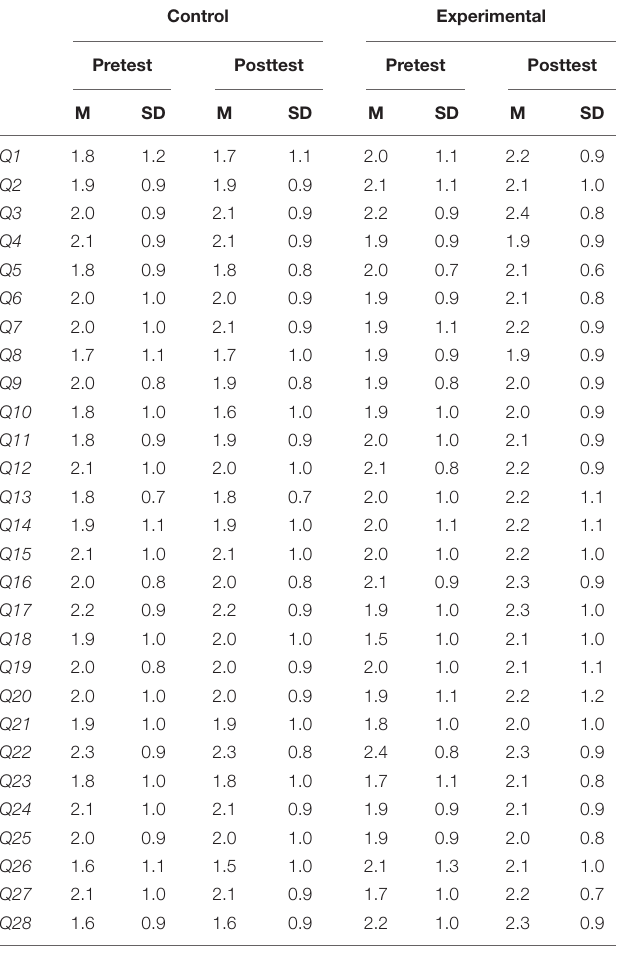
TABLE 5 | Mean and std. deviation of the questionnaire scores for learners of the control and experimental groups before and after the treatment. Control Experimental